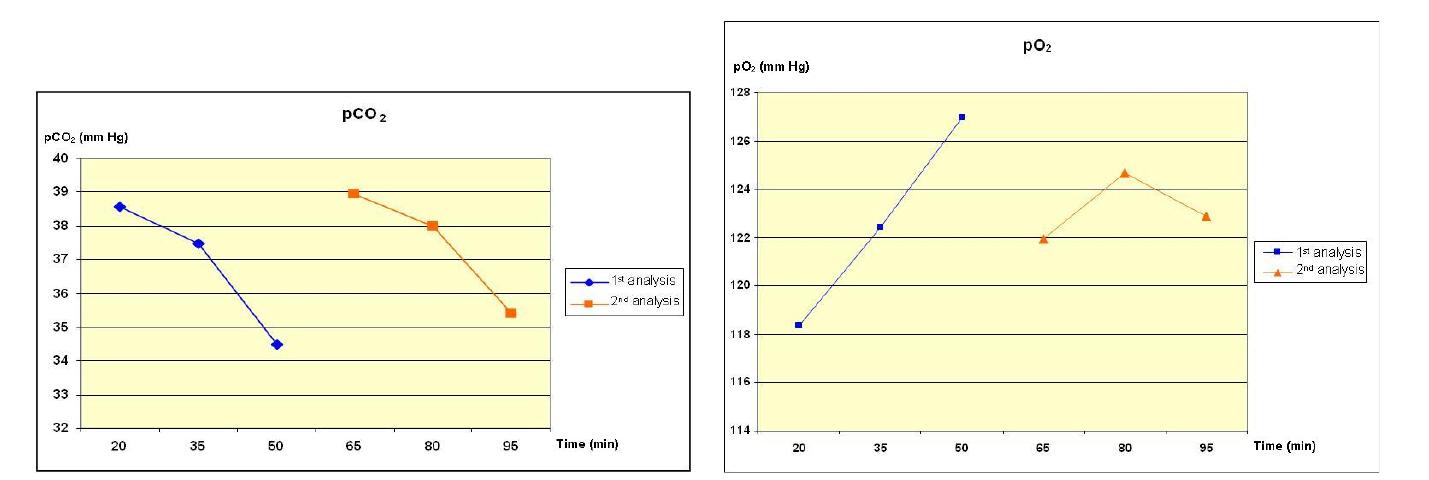
FIGURE 2 – pO average values in the first and second gasometrical 2 analysis during the blood storage on ice